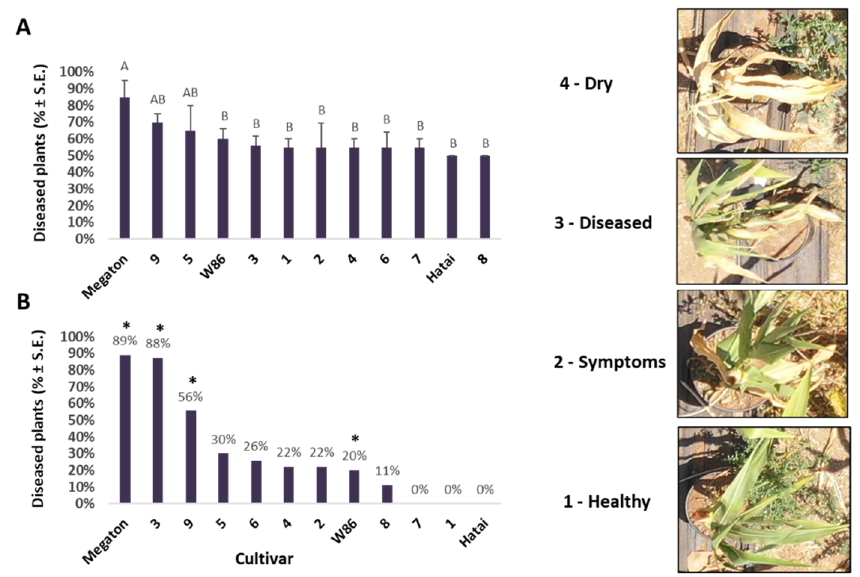
Figure 8. Evaluation of symptom severity from aerial imaging near the season’s end (92 days after sowing). Disease severity was evaluated according to four categories (right panel). The experiment is described in Figure 3. Values indicate the mean of five repeats (pots, each having one plant). ( A ) The percentage of diseased plants in the soil inoculation treatments. Vertical upper bars represent the standard error. Different letters above the bars represent a significant difference ( p < 0.05) in an analysis of variance (ANOVA) assay. ( B ) The percentages of diseased plants compared to the control